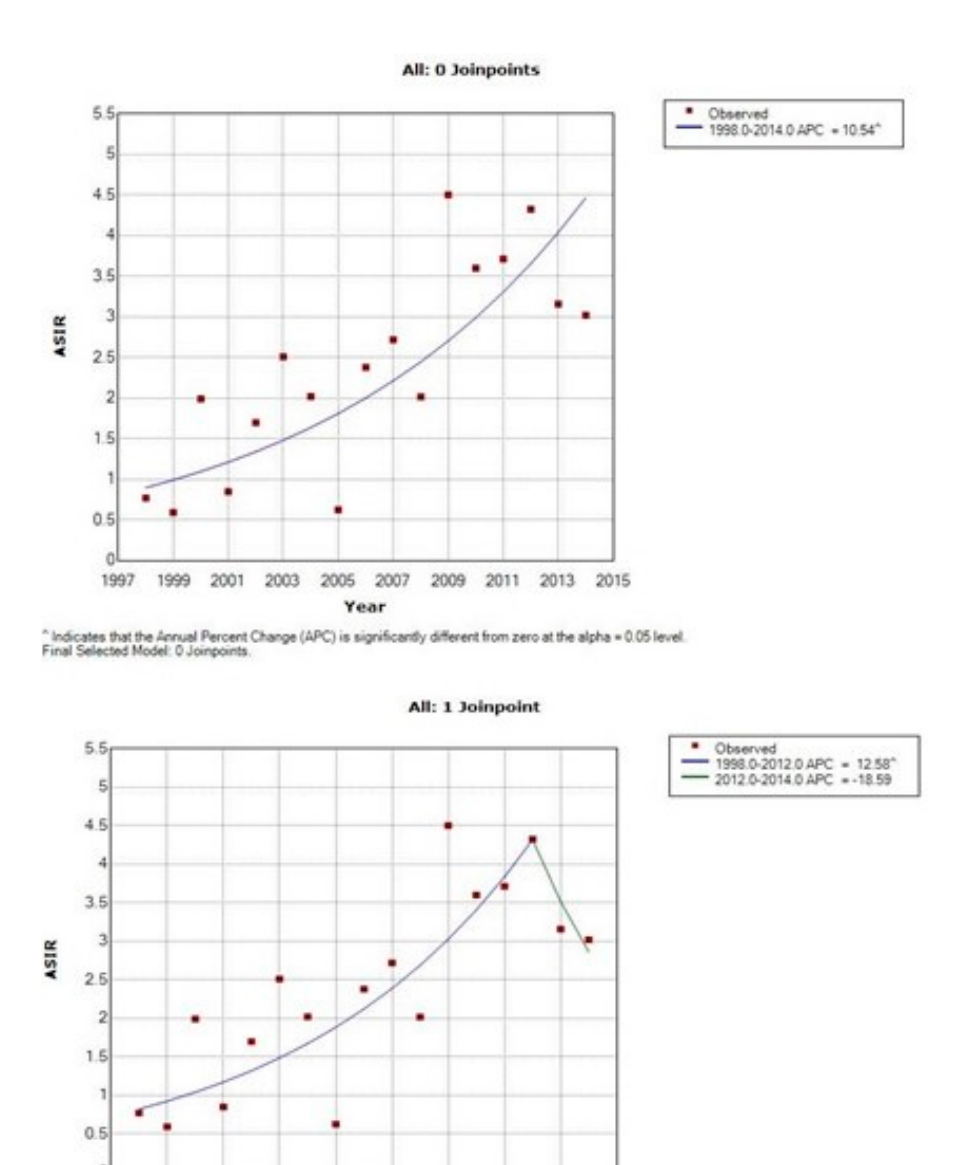
Table 5. Quality control of data on cervical cancer cases registered at the Territorial Cancer Registry of the North-Western Region of Romania, period 1998–2014.